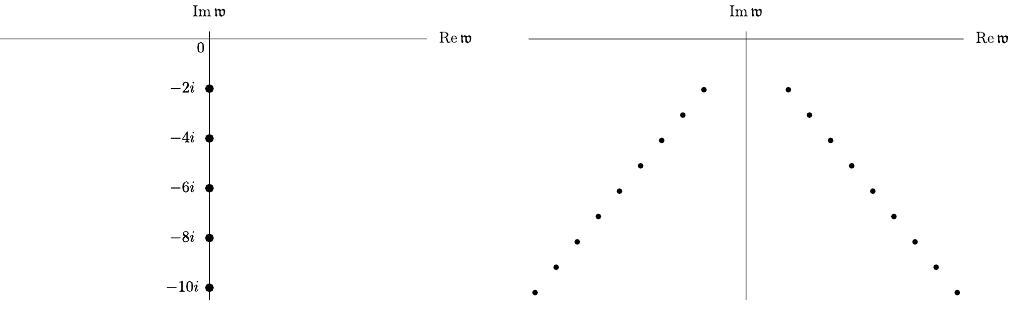
Figure 8 . Singularities of a thermal retarded two-point function G R ( w ; q ) at q = 0 in the complex frequency plane at zero coupling [10] (left panel) and in(cid:12)nitely large coupling [5] (right panel). on the imaginary axis with periodicity j w j = 2, as shown in the left panel of (cid:12)gure 8. At in(cid:12)nite coupling, the same correlator has poles that are still arranged in the \Christmas tree" pattern, similar, although not identical to the q 6 = 0 spectrum ((cid:12)gure 8, right